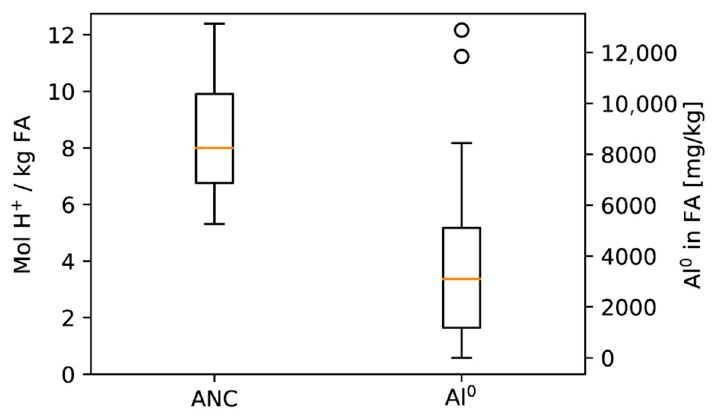
Figure 4. Boxplot of the acid neutralizing capacity (ANC) as amount mol H + to reach pH 2 at a L / S ratio of 10 and Al 0 in Swiss FA (n = 29).